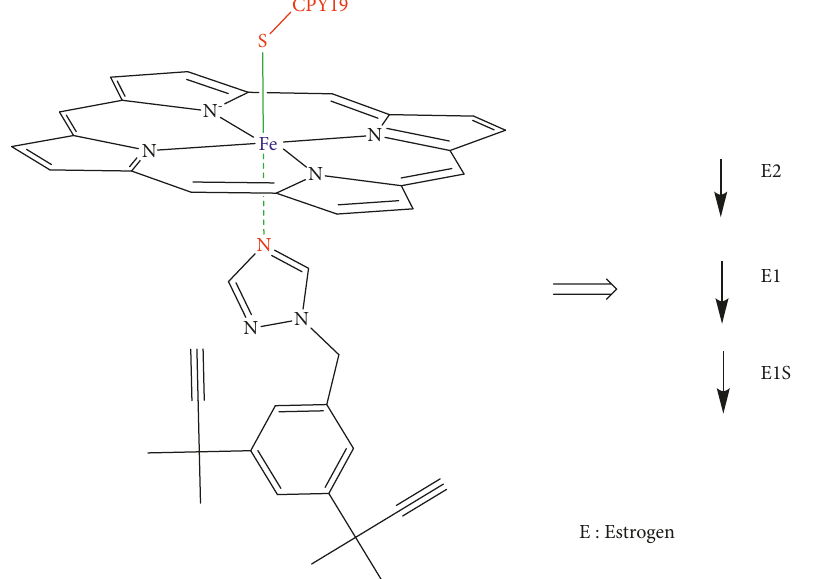
Figure 2: Mechanism of action of anastrozole.